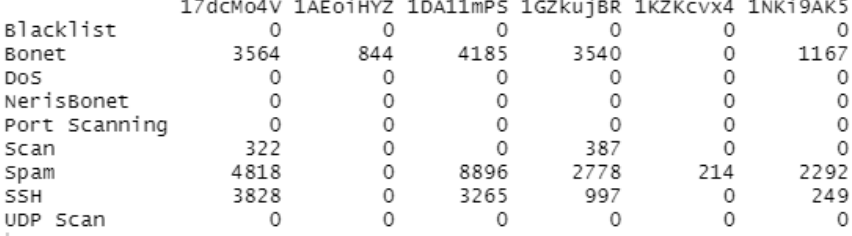
Figure 34. The stratification results of the Decision Tree algorithm that predict that zero-day threats will be using spamming for intrusion in the near future. Nevertheless, phishing might also be used. Figures 35 and 36 illustrate the prediction of the Decision Tree algorithm.